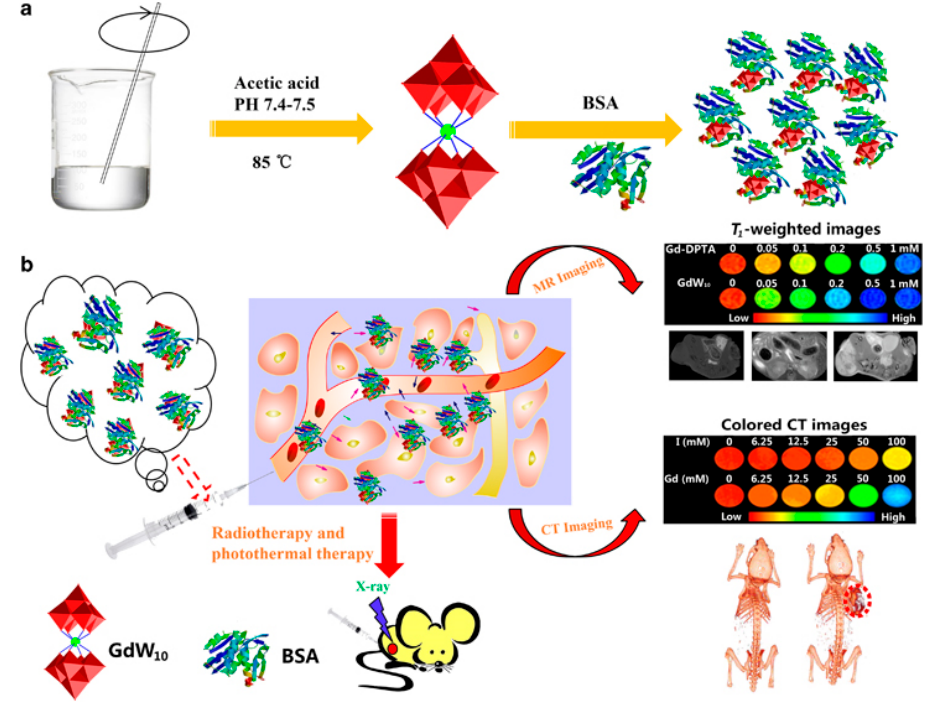
Figure 3. Schematic illustration of gadolinium polytungstates nanoclusters GdW10@BSA NCs for dual-modal magnetic resonance (MR) / computed tomography (CT) imaging-guided photothermal therapy/radiotherapy of cancer. ( a ) The synthesis process of GdW10@BSA; ( b ) The application of the as-made GdW10@BSA for bio-imaging and treatment of tumor. Image from [29]. Article distributed under a Creative Commons CC-BY license.